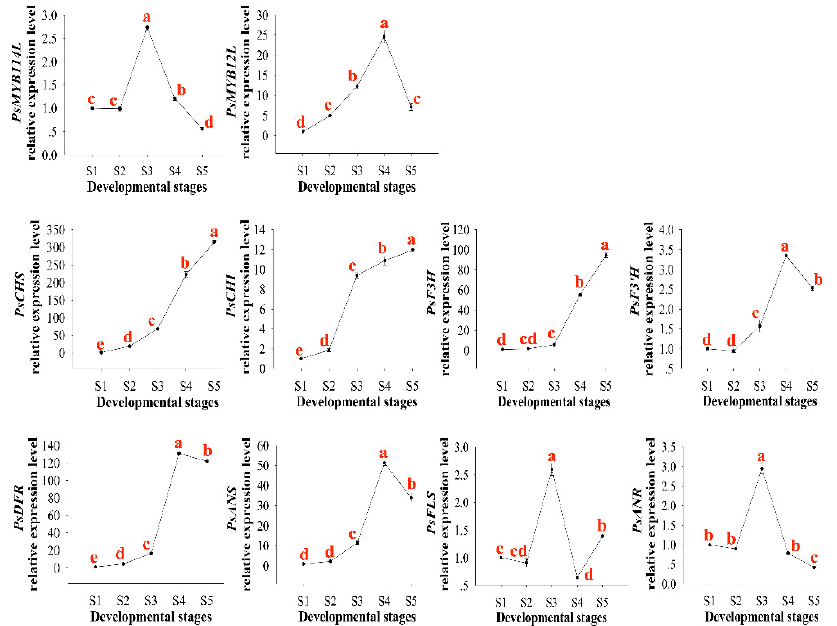
Figure 5. The expression patterns of the PsMYB114L gene, PsMYB12L gene and anthocyanin biosynthesis-related structural genes in P. suffruticosa ‘Shima Nishiki’. S1, flower bud emerging stage; S2 small bell-like flower-bud stage; S3, large bell-like flower-bud stage; S4, bell-like flower-bud extending stage; S5, color exposing stage. Different lowercase letters indicate significant differences at P < 0.05.